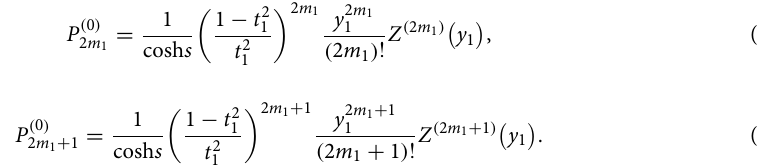
Figure 3. ( a , b ) 2 m , 2 m The plots demonstrate the dependencies of the parameter ( a ) y 2 m fidelities in Fig. 2 if either y k the smaller the value of the parameters y 2 m fidelity of the conditional